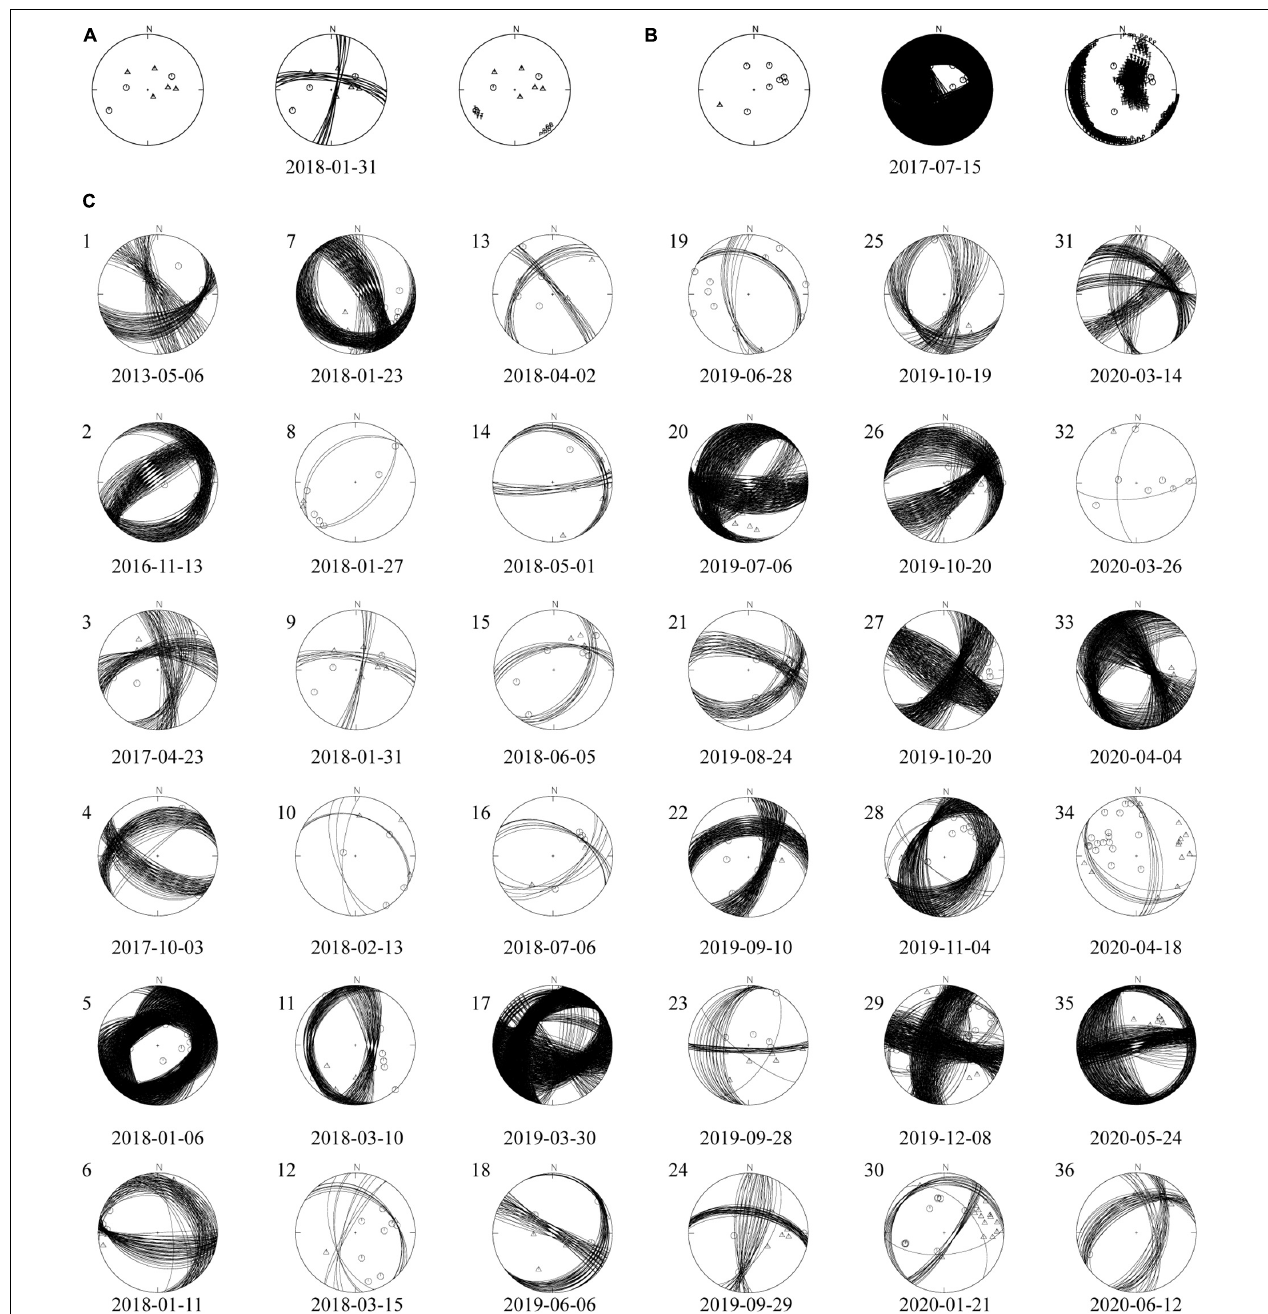
FIGURE 4 | FocMec solutions: (A) Example of an accepted event solution (case of the January 31, 2018 earthquake); (B) example of a discarded event solution (case of the July 15, 2017 earthquake). From left to right, the P-wave polarity distribution, the fault plane solutions, and the P-T axes distribution are shown in the focal spheres. (C) The 36 accepted focal mechanisms according to the criteria described in the Focal Mechanism Determination section. Dates below the solutions refer to the origin time of the event ( Table 1 ).